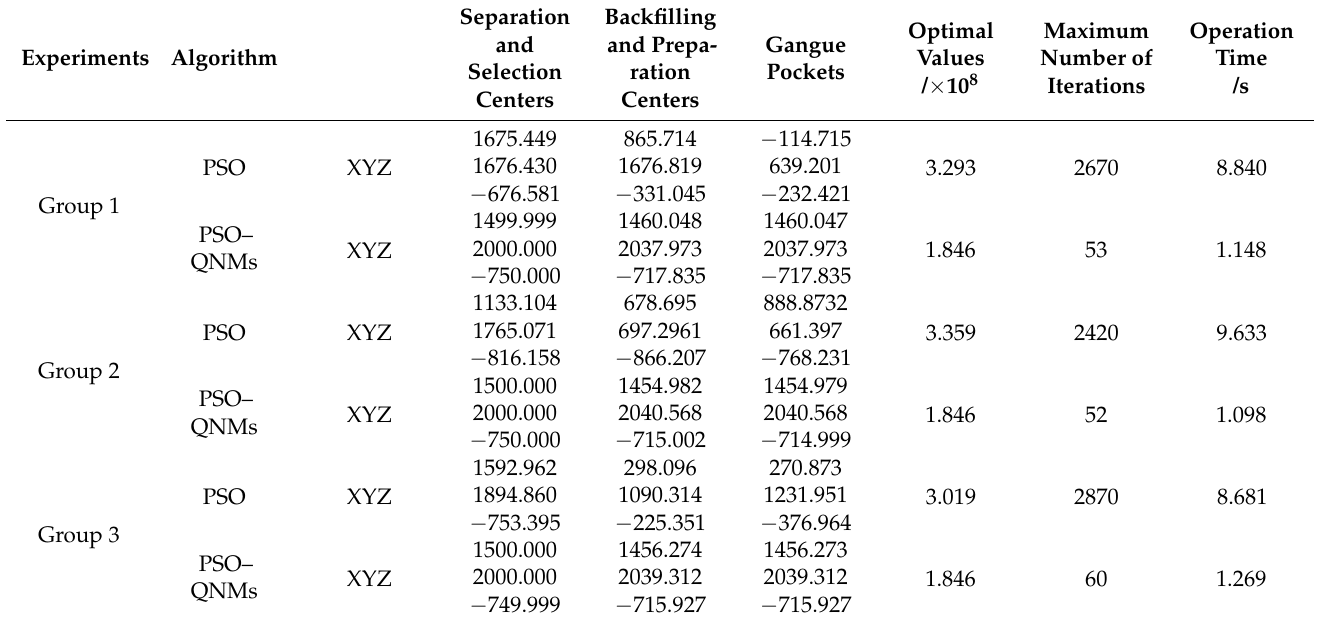
Table 3. Simulation experiment